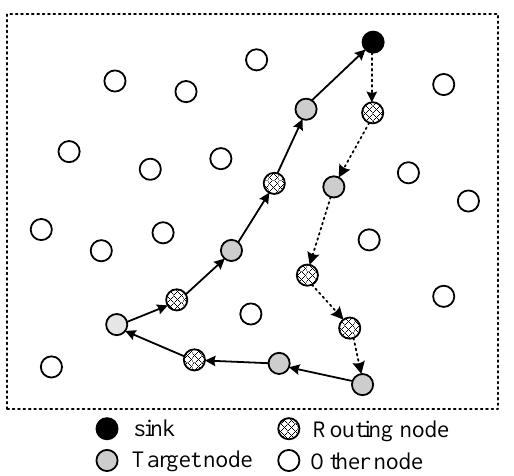
Figure 4. Single-ring structure.